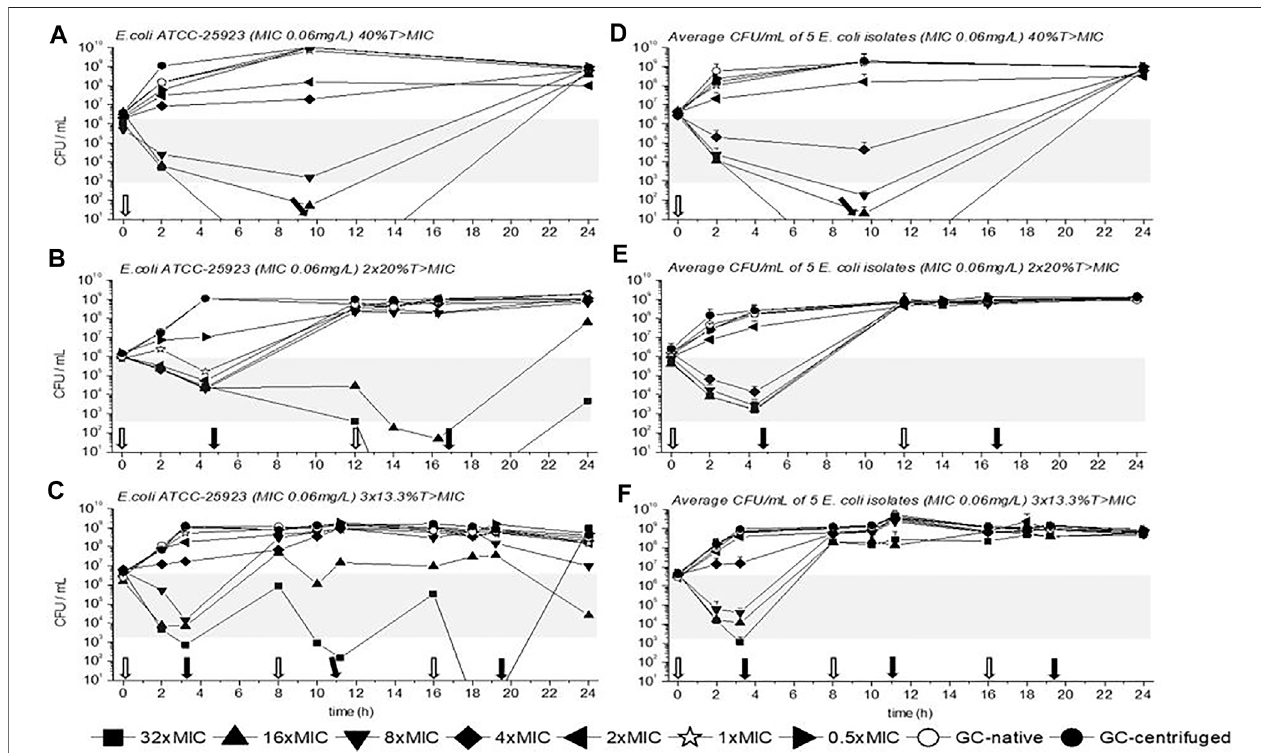
FIGURE3| Timekillcurves(TKC)withmeropenemof E.coli ATCC-25923 (A) , (B) , (C) andoftheaverageCFU/mLof fi ve E.coli isolates (D) , (E) , (F) areshownover 24 hwithstandarddeviation.In (A) , (B), and (C) thestandarddeviationsareverysmallandoverlaidbysymbols.Thecircularsymbolsrepresentthegrowthcontrols, fi lled show the centrifuged, and empty depict the native GC. The concentration of the MIC of the tested strains is given as a star symbol. Empty arrows indicate antibiotic addition and fi lled arrows indicate antibiotic